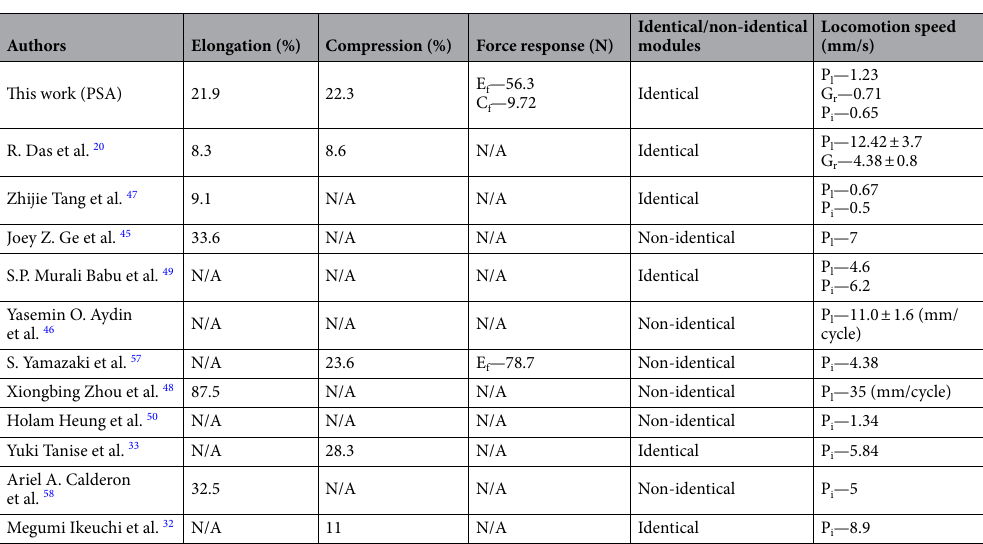
Table 1. Pneumatically powered soft peristaltic robots and their performance. E elongation, C compression, P l planar surface, G r granular surface, P i pipe crawling, E f longitudinal force, C f translated radial